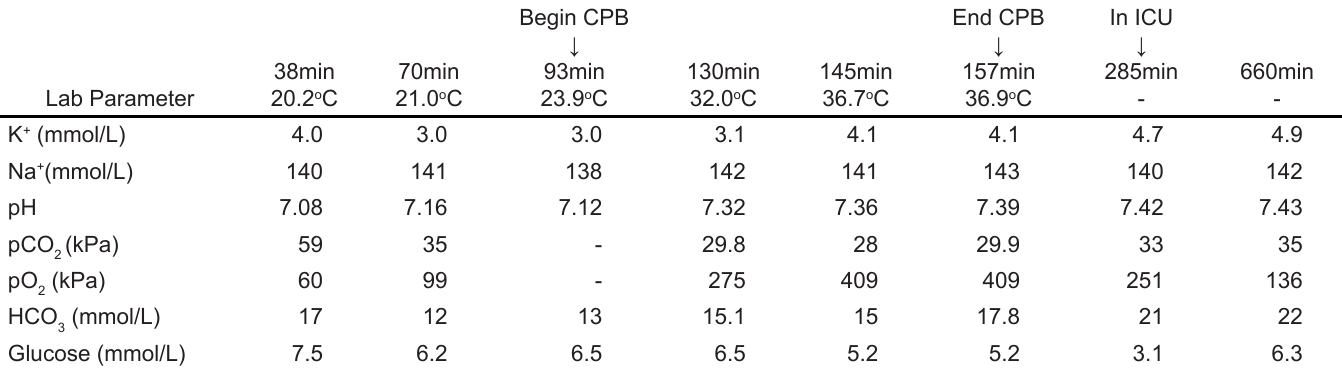
Table. Blood sample measurements in relation to time of presentation to the ED and core body